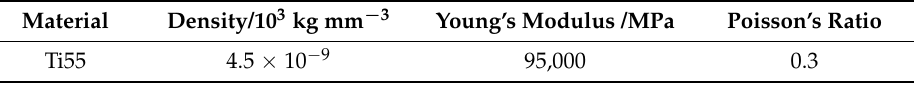
Figure 2. Schematic diagram of hot press forming of the curvilinear generatrix workpiece of Ti55 alloy.